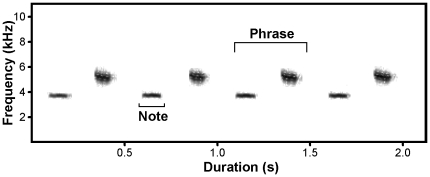
Spectrographic representation of great tit song.This figure shows a complete strophe of a two notes song type, indicating what constitutes a phrase and a note.